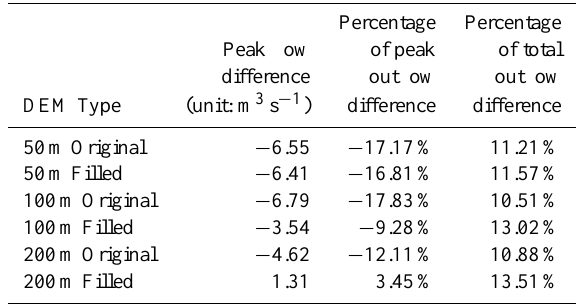
Fig. 11. Accumulative surface water depths during model simula- tions. Table 4. Statistics of the peak flow in whole catchment